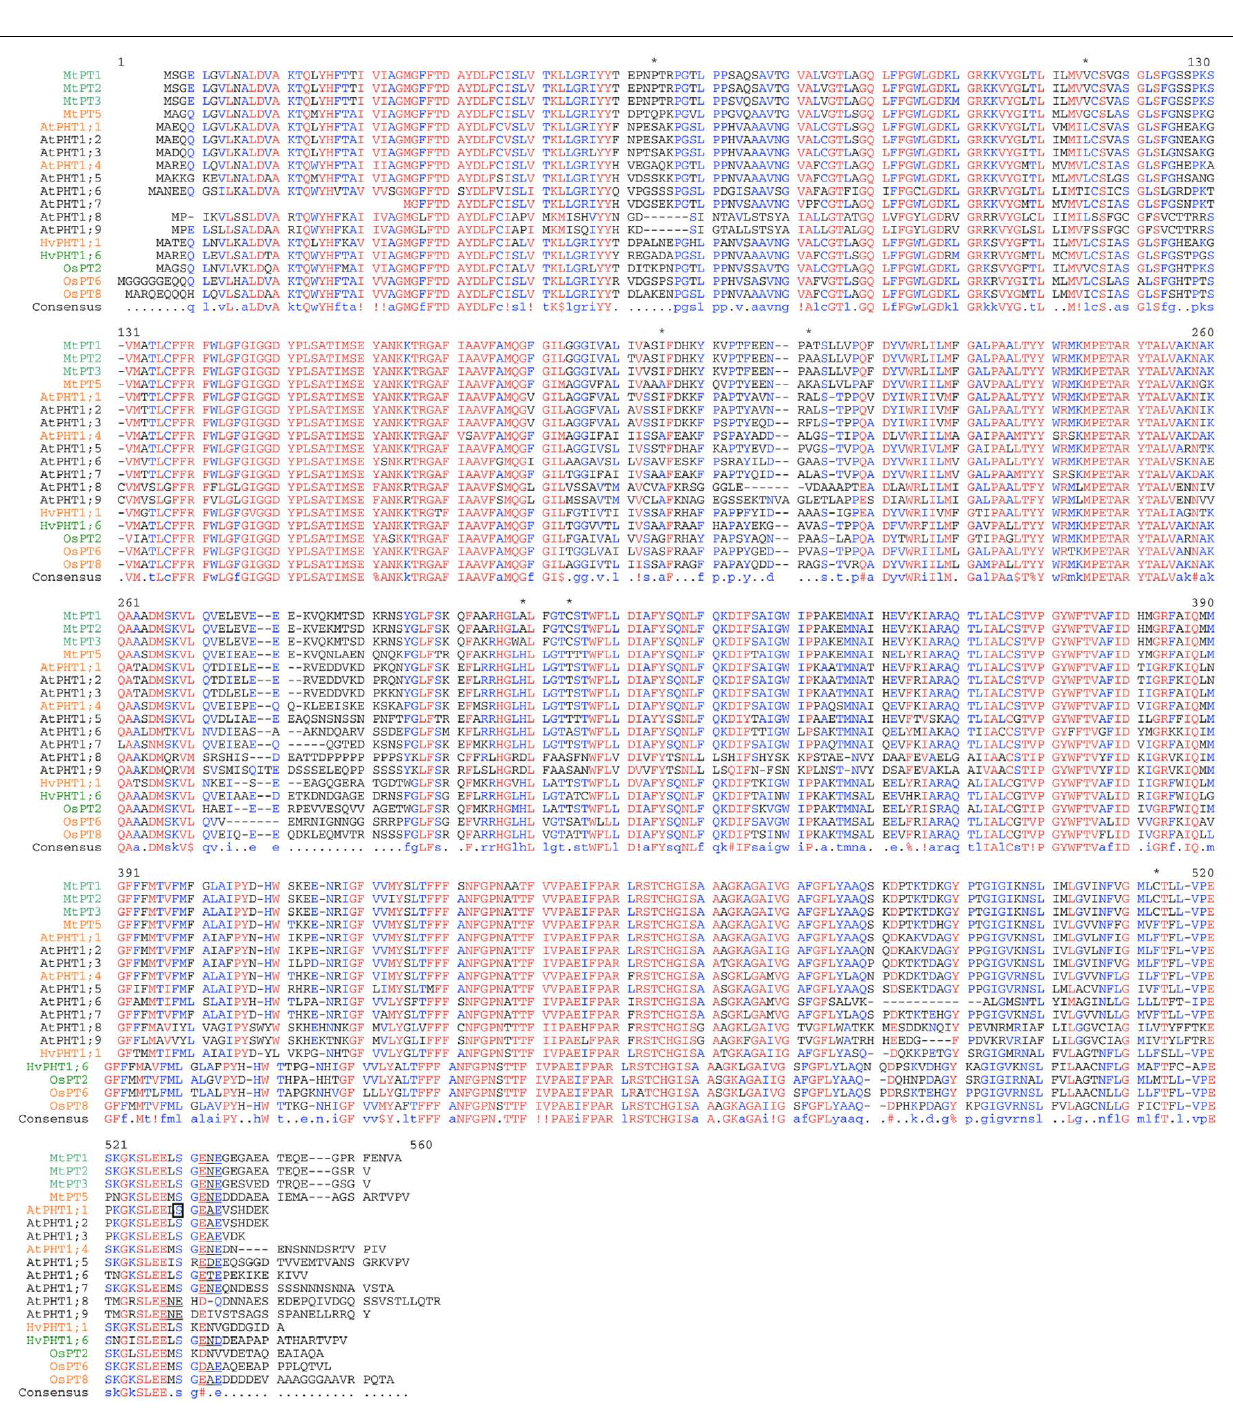
FIGURE 1 | Sequence alignment of several PHT1 transporters from Medicago truncatula (Mt), Arabidopsis thaliana (At), Hordeum vulgare (Hv), and Oryza sativa (Os). High or low affinity characterized PHT1 are indicated by orange or green colors respectively. Stars indicate the 7 amino